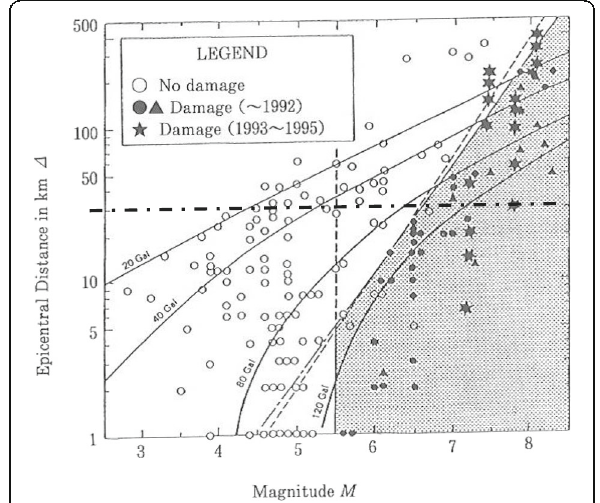
Fig. 5 Railway damage evaluated on a magnitude (M)-epicentral distance ( Δ km) diagram. This is a copy of Fig. 2 in Nakamura (1996) with slight modification (courtesy by Y. Nakamura). The dashed horizontal line indicates the epicentral distance of 30 km. For M > 6.5, damage occurred at sites of Δ > 30 km. For ~ 5.5 < M < 6.5, there was damage at some sites with Δ < 30 km